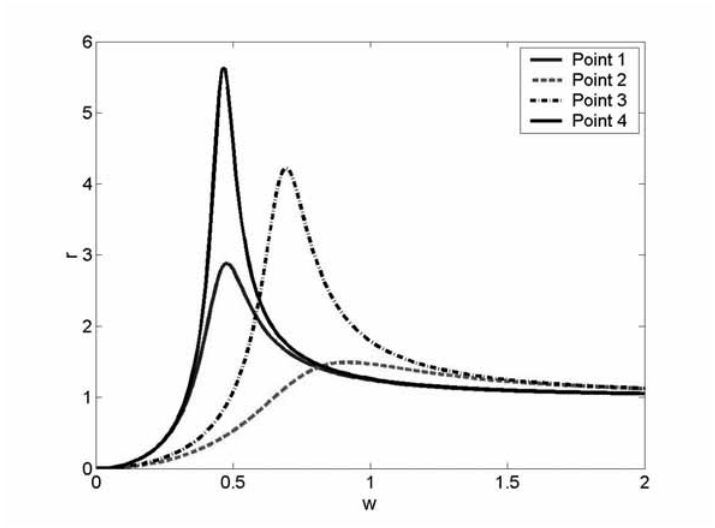
Fig. 25. Optimized relative displacement frequency responses.